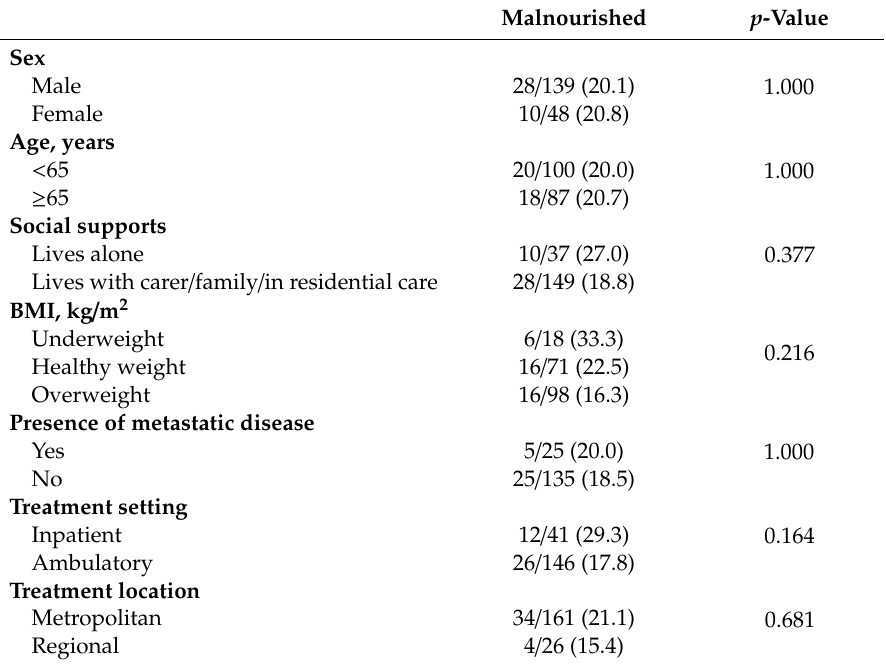
Table 7. Factors associated with